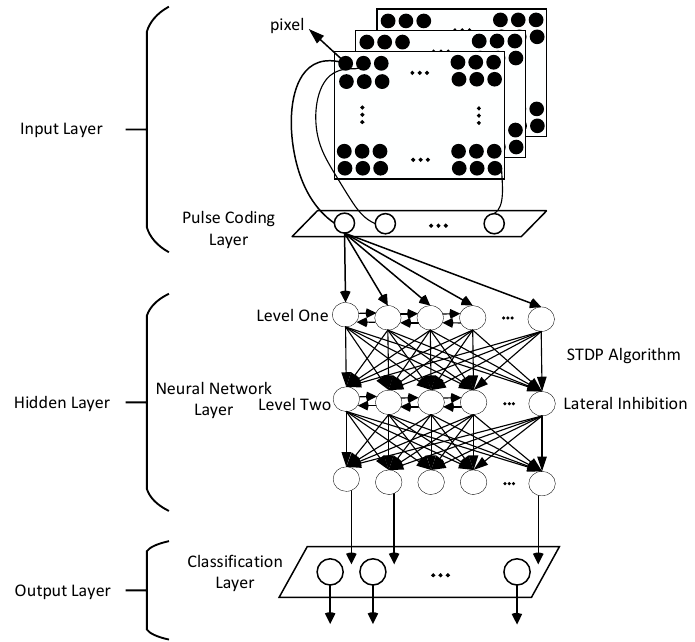
Figure 1. Structure of Neural Network.